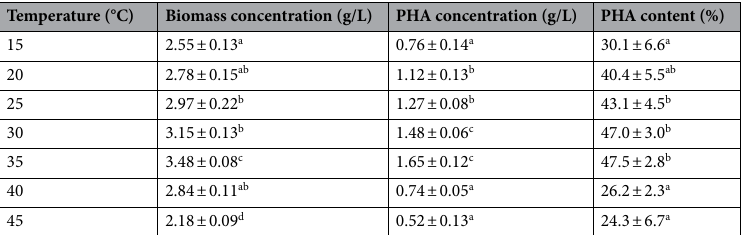
Table 1. Effect of temperature on the growth and PHA synthesis of Pichia sp. TSLS24. In a column, data with different superscript are significant with P < 0.05.